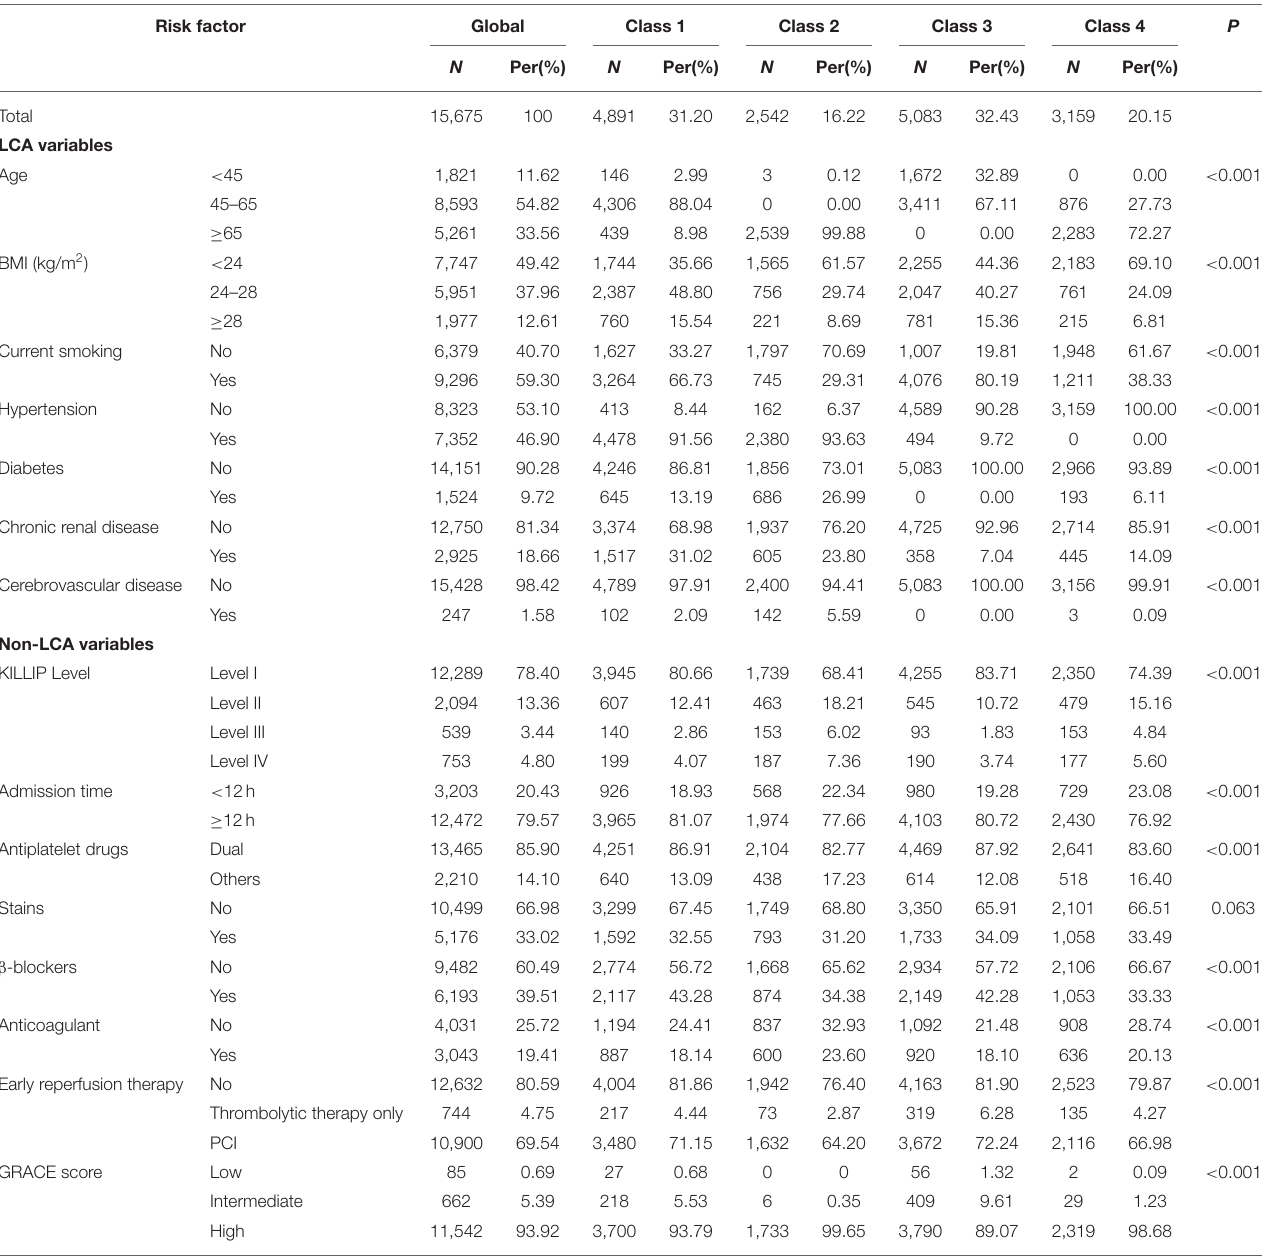
TABLE 1 | Characteristics of risk factor